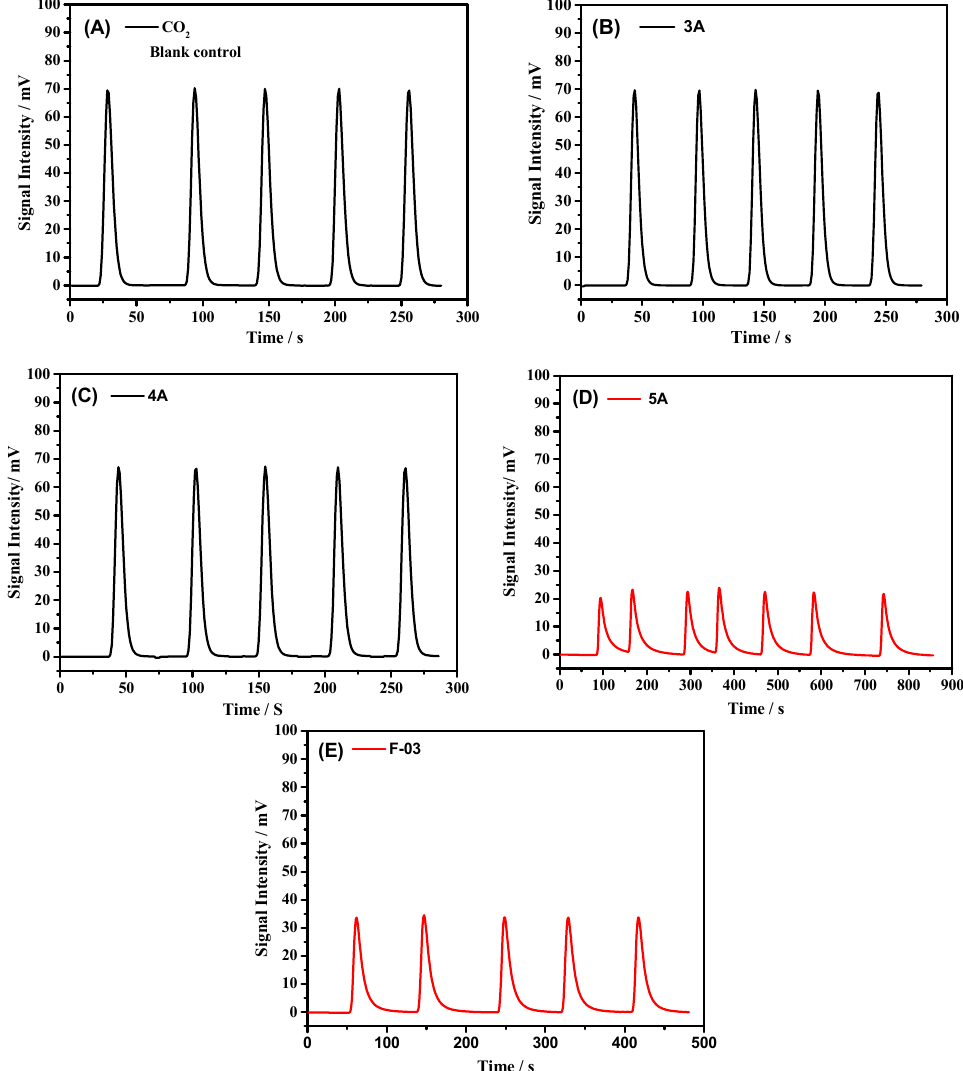
Figure 6. Adsorption performance of adsorbent materials with CO 2 tested with pulse adsorption, ( A ) Blank control, ( B ) 3A, ( C ) 4A, ( D ) 5A molecular sieve, ( E ) F-03.